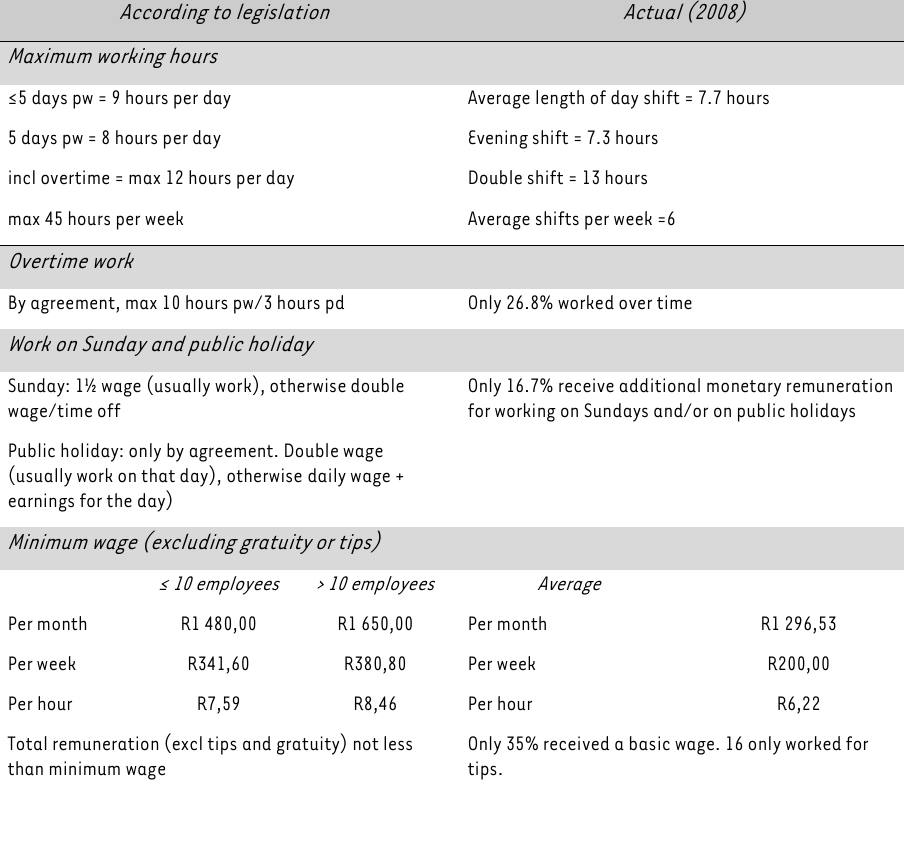
TABLE 3: Comparison between the de jure and actual remuneration and working conditions of waiters in Kempton Park in